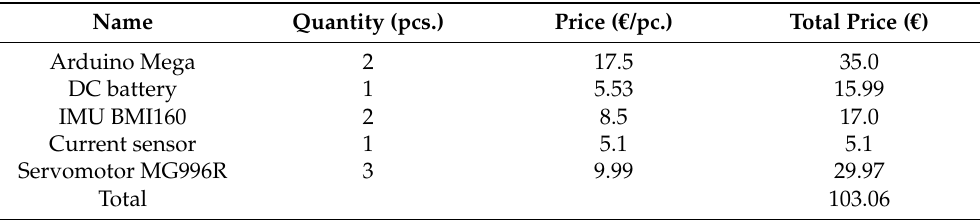
Table 5. The price of the